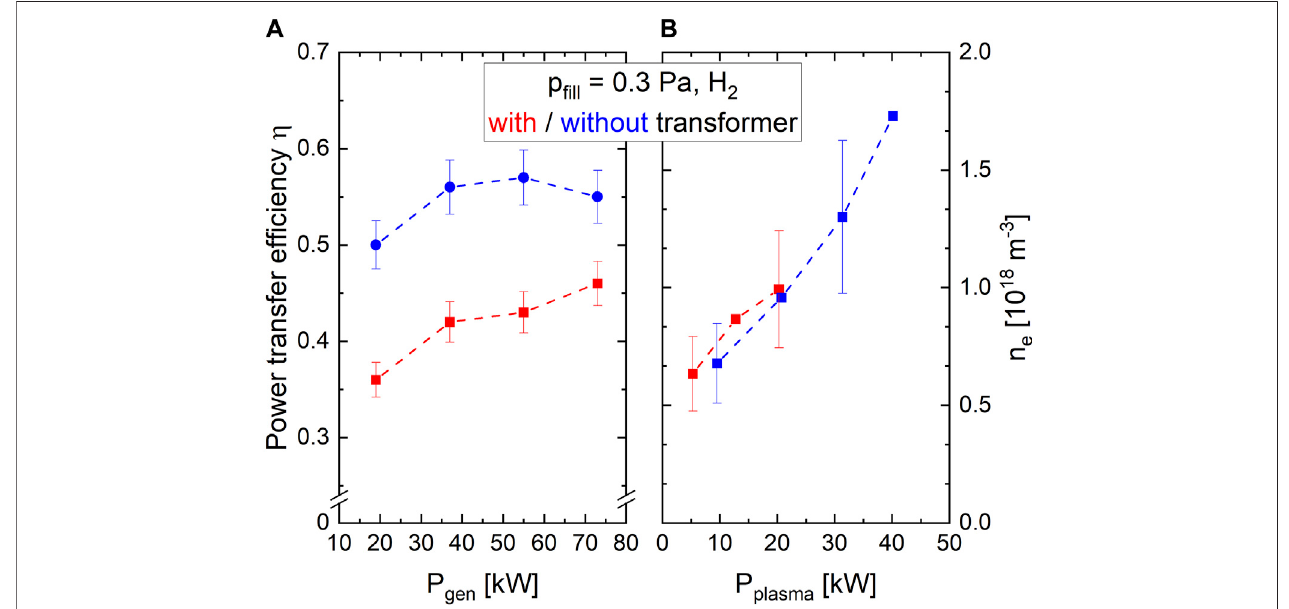
FIGURE 2 | RF power transfer ef fi ciency at BUG for varying generator power P gen (A) and electron density obtained from Langmuir probe measurements in the driver center plotted as a function of the power absorbed by the plasma P plasma (B) . The fi gure is adapted from [22].